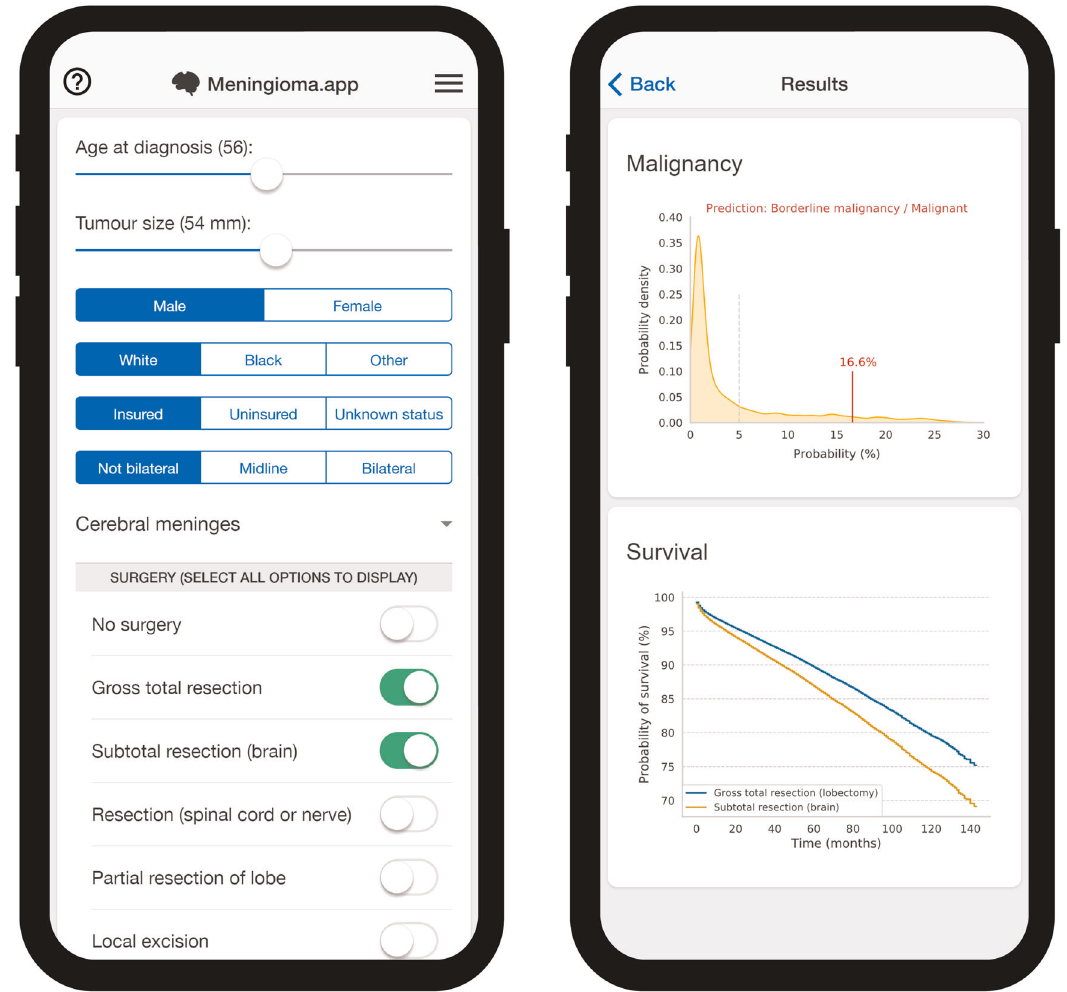
Fig. 5 Example predicted malignancy and survival curves for an insured 56-year-old white man with a unilateral 54 mm wide meningioma localizing to the cerebral meninges. Try the app at